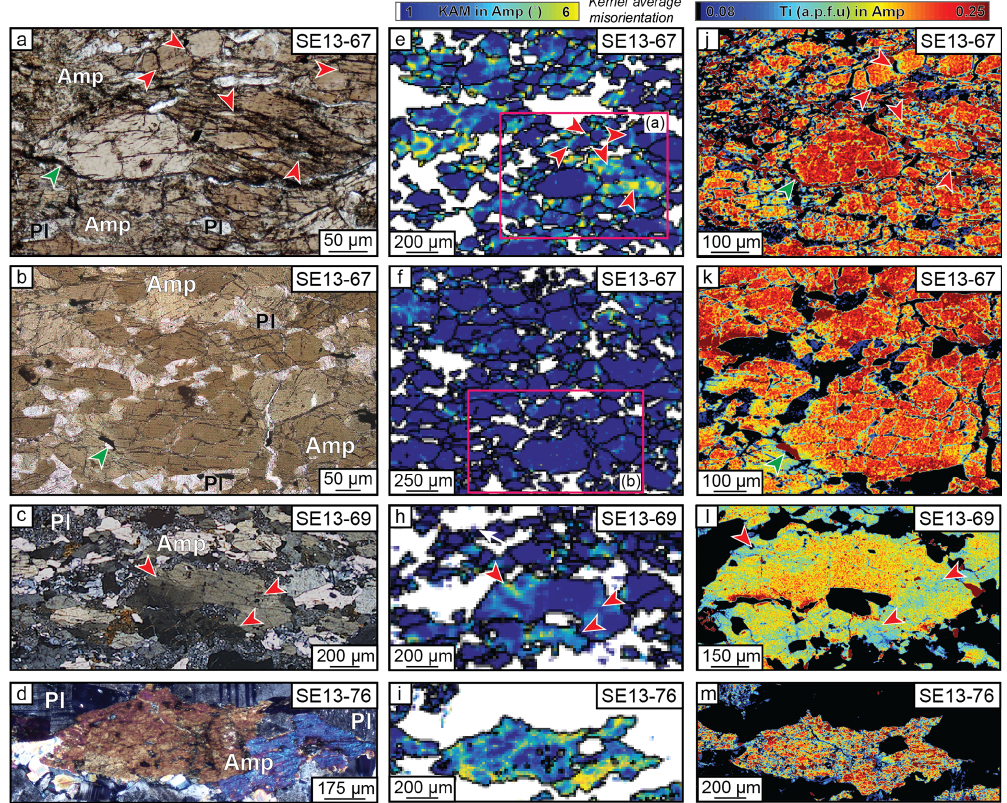
Figure 6. (a–d) Photographs of representative textures of amphibole, (e, f, h, i) (2–10 ◦ ) intracrystalline misorientation (to the mean grain orientation) and (j–m) compositional map of Ti of amphibole in samples sorted as a function of the distance from the peridotite. Red and green arrows point to amphibole microfractures and ilmenite veinlets or crystals, respectively.